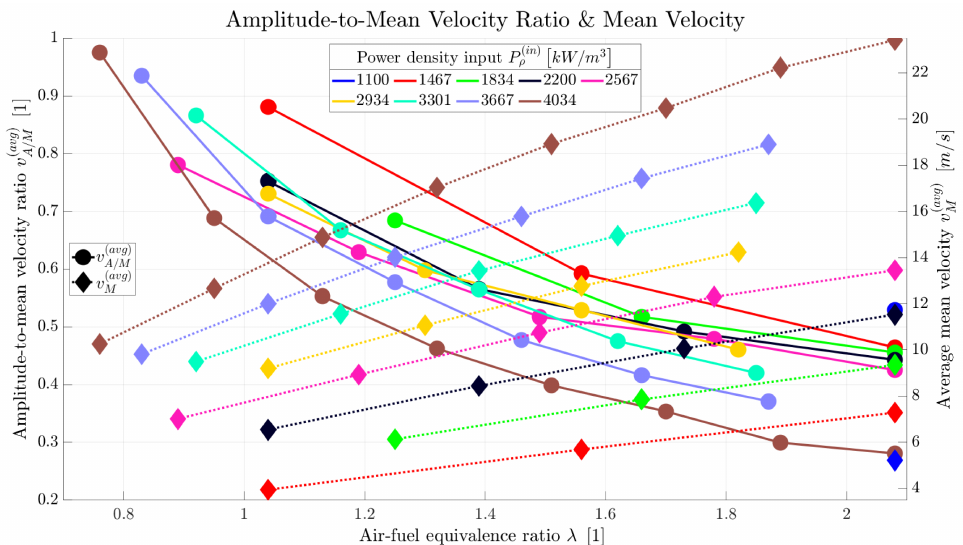
Figure 13. The average velocity amplitude and the average mean velocity ratio displayed together with the average mean velocity.